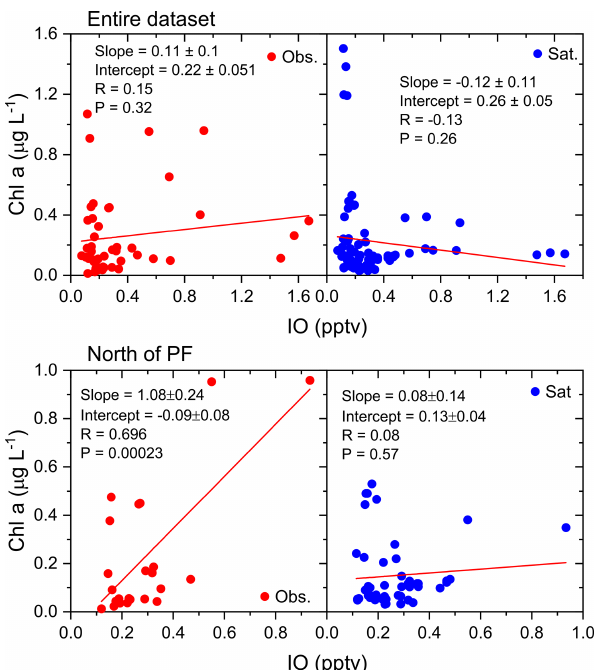
Figure 9. Linear fit of daily averaged field observations of chloro- phyll a (red circles) and chlorophyll a satellite data (blue circles) ( y axis) against observed iodine monoxide (IO) ( x axis) from the ISOE-8, IIOE-2, and ISOE-9 campaigns. The top panels include chlorophyll a for the entire dataset; the bottom panels include data to the north of the polar front.